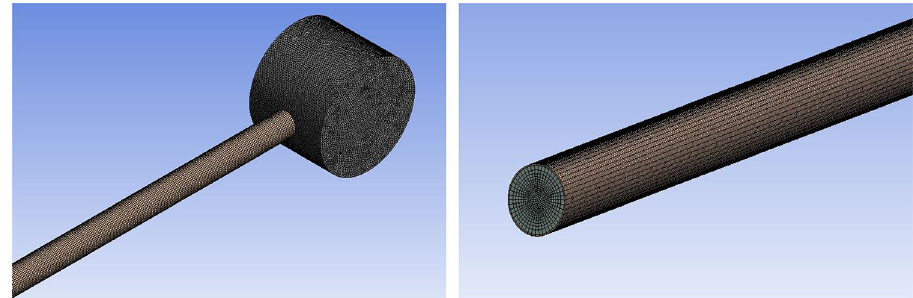
Figure 2. The style of the grid structure.